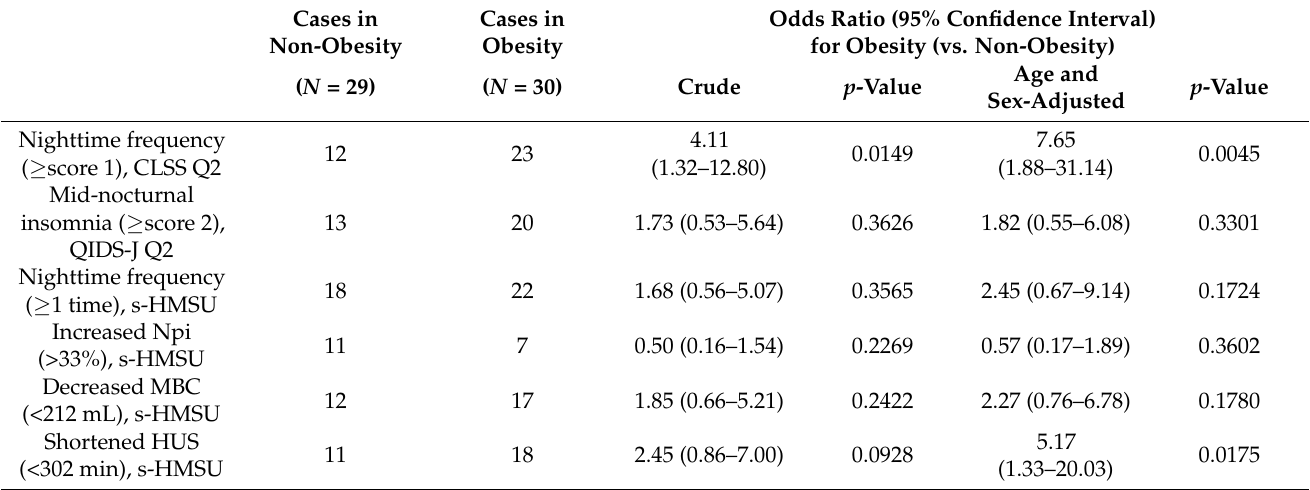
Table 4. Odds ratios of voiding abnormalities for obesity (vs.